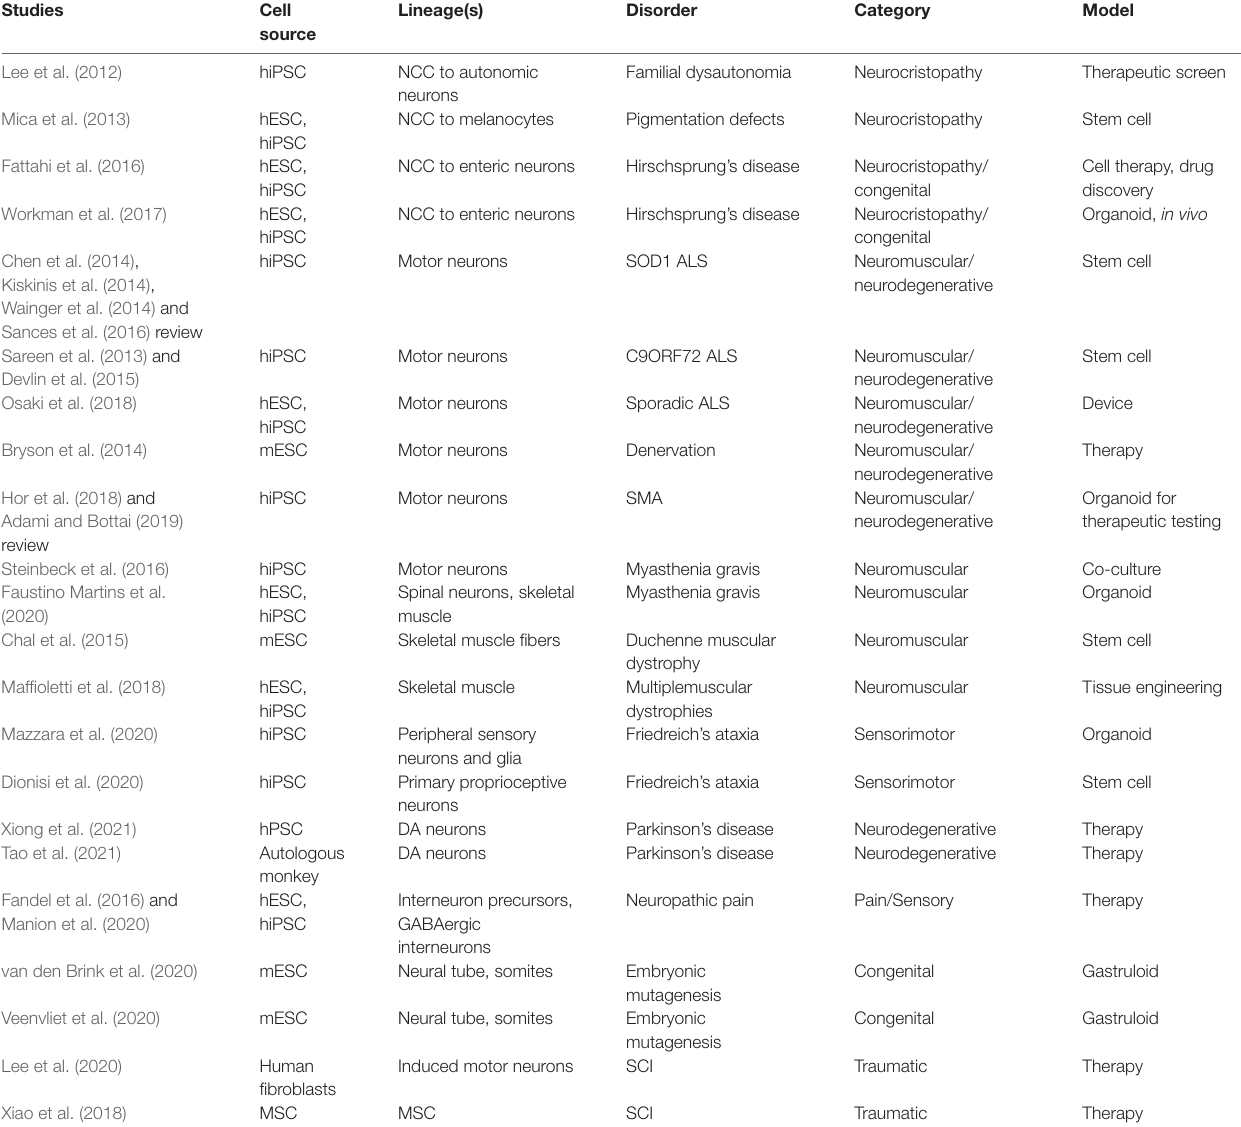
TABLE 1 | Stem cell technologies for trunk and spine disease modeling and therapy (select